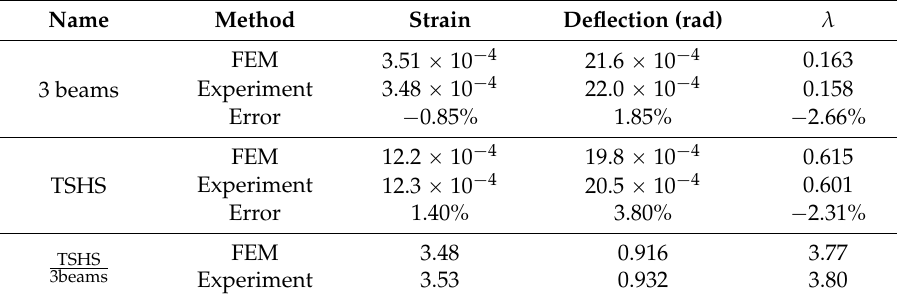
Table 4. Comparison experiment result with